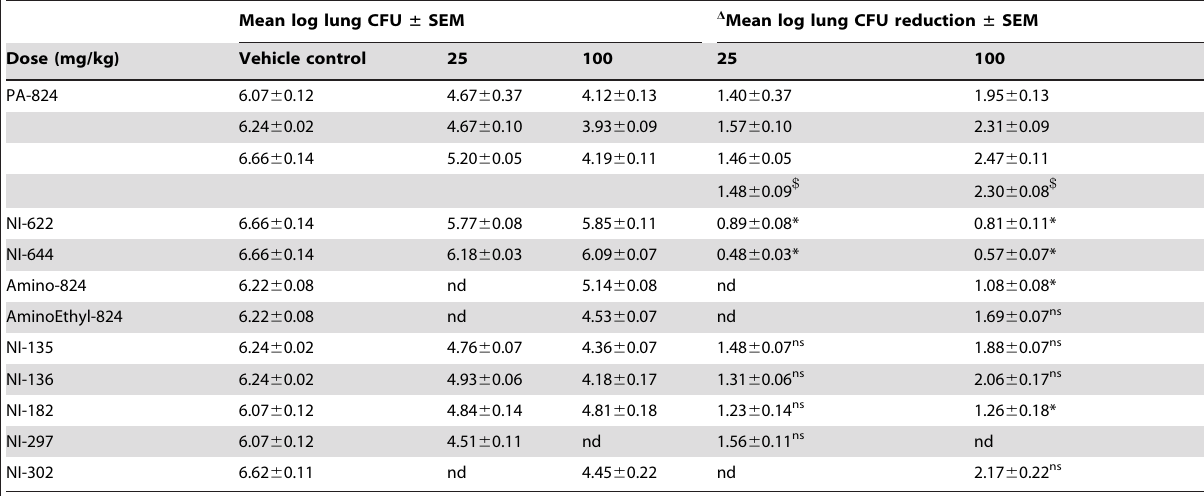
Mean log lung CFU ± SEM